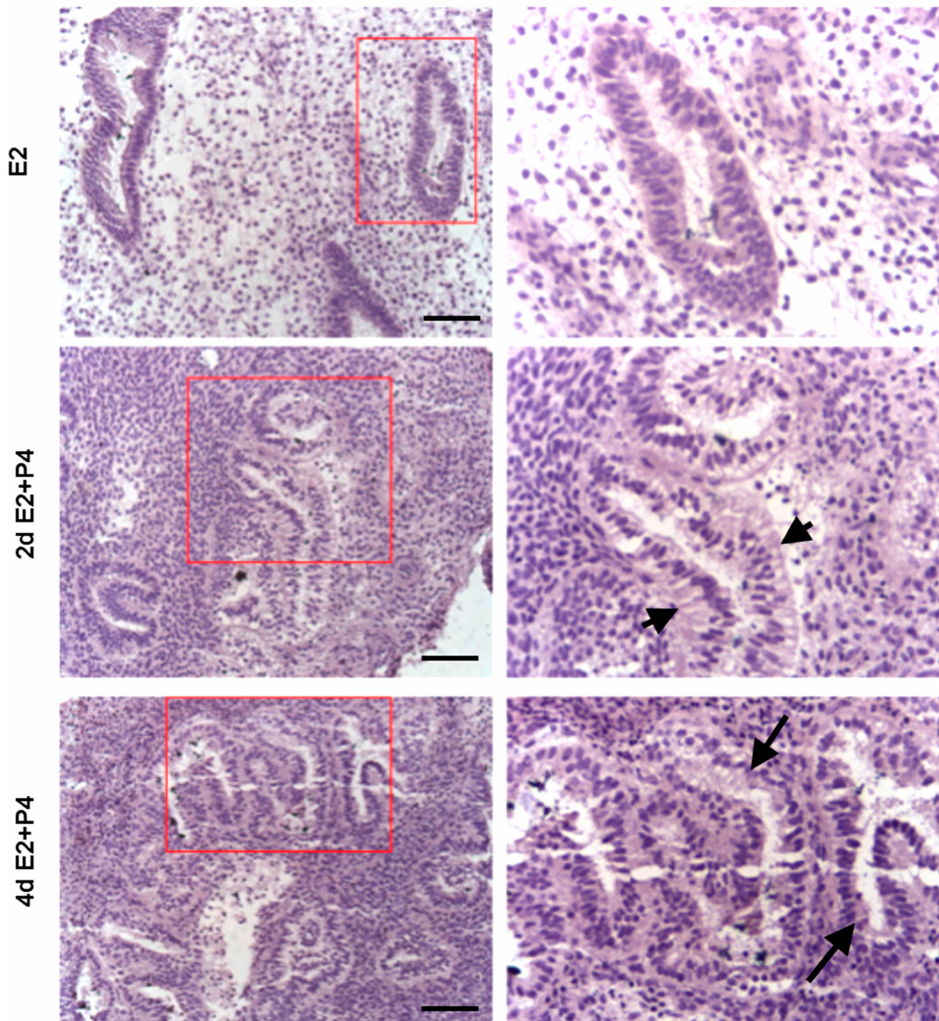
Figure 7. Histology of endometrial slices following E2 and di ff erent durations of E2 + P4 treatments. Arrow heads show subnuclear vacuolation in glands after treatment with 2 days of E2 + P4. Arrows show supranuclear vacuolation in glands after treatment with 4 days of E2 + P4. Scale bar 200 µ m; Original magnification 160 ×